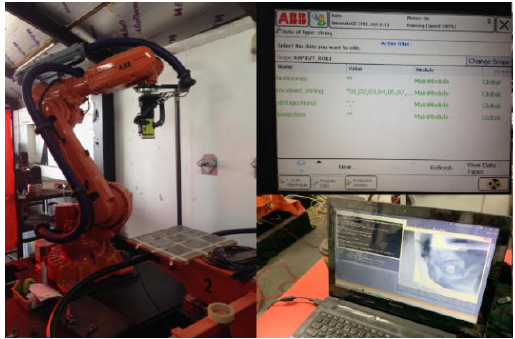
Figure 9. Main components of reconditioning cell during integration testing.